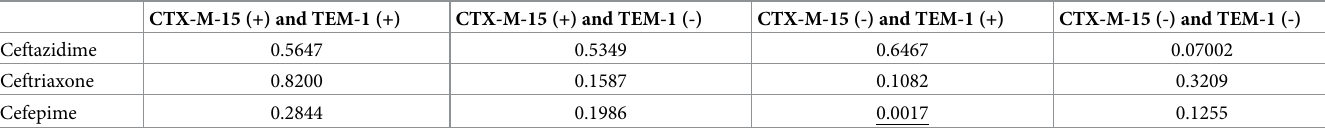
Table 2. P-values for Shapiro-Wilk normality test with combined resistance genes. For each condition we test for normality with the Shapiro-Wilk Normality Test. All cases except one (growth rates for isolates with no CTX-M-15 and TEM-1 in presence of cefepime) indicate normality (with p < 0.01). CTX-M-15 (+) and TEM-1 (+) CTX-M-15 (+) and TEM-1